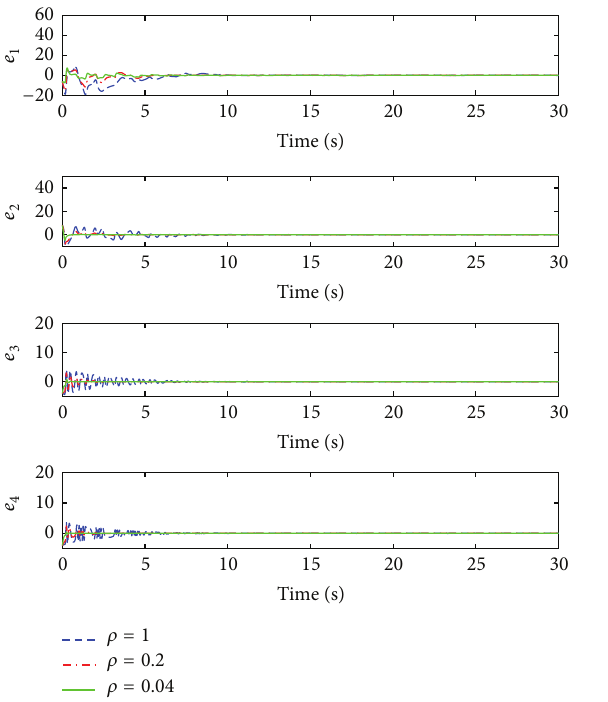
Figure 4: The states of the error dynamical system (7).